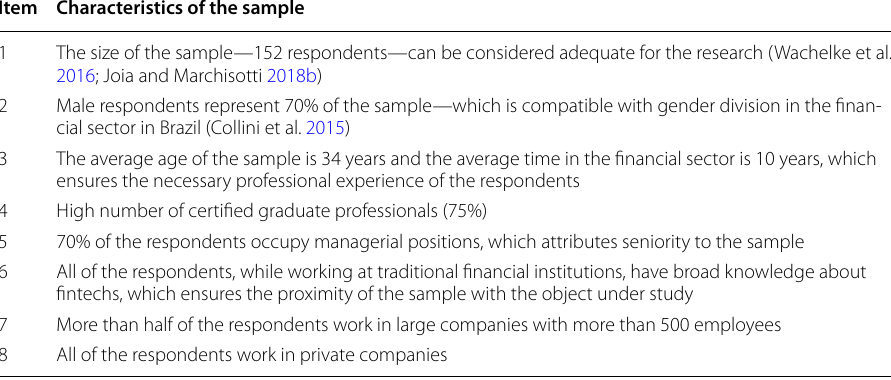
Table 2 Description of the sample Item Characteristics of the